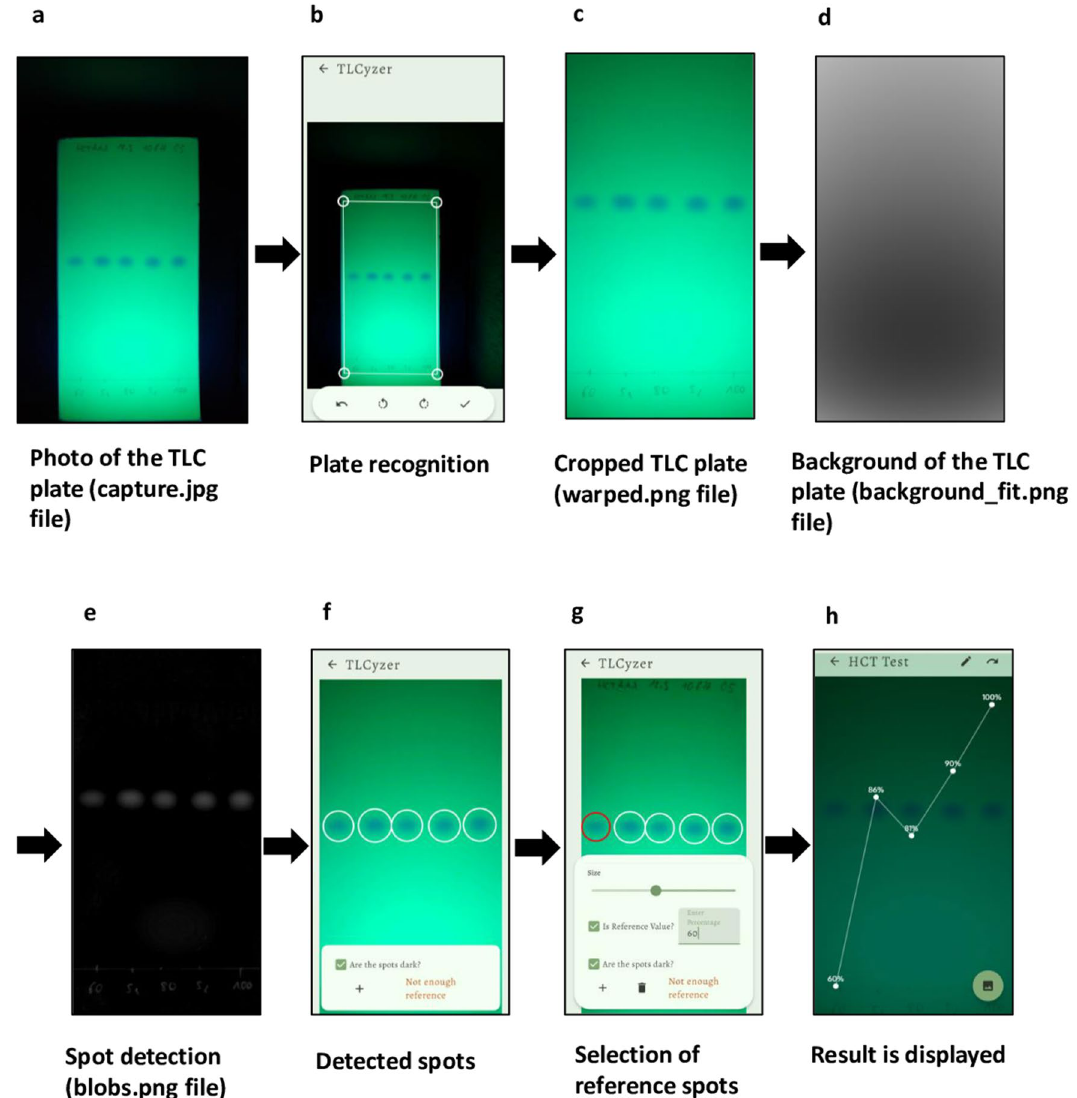
Figure 2. Multi-stage capture and processing pipeline of a photo of a TLC plate in the TLCyzer imaging application. The TLC plate is photographed ( a ) and the outlines of the plate are defined, perspectively warped, and cropped ( b , c ). The background is then fitted on the result and removed from the grayscale input ( d ). The result leaves only the blobs, which are detected by thresholding and connected component analysis ( e ). The now detected spots ( f ) are then integrated, and content value (= percentage) is manually entered for each reference spot ( g ). By fitting a linear function, the contents (= percentages) of the unknown samples are evaluated ( h ). A spotting pattern with three reference solutions (60, 80 and 100%) was used in this TLC plate (see Supplementary Fig.